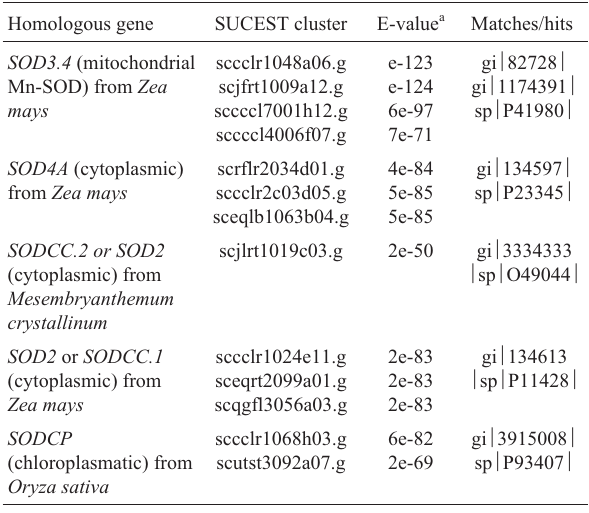
Table VI - Superoxide dismutase (SOD) homologues in sugarcane.